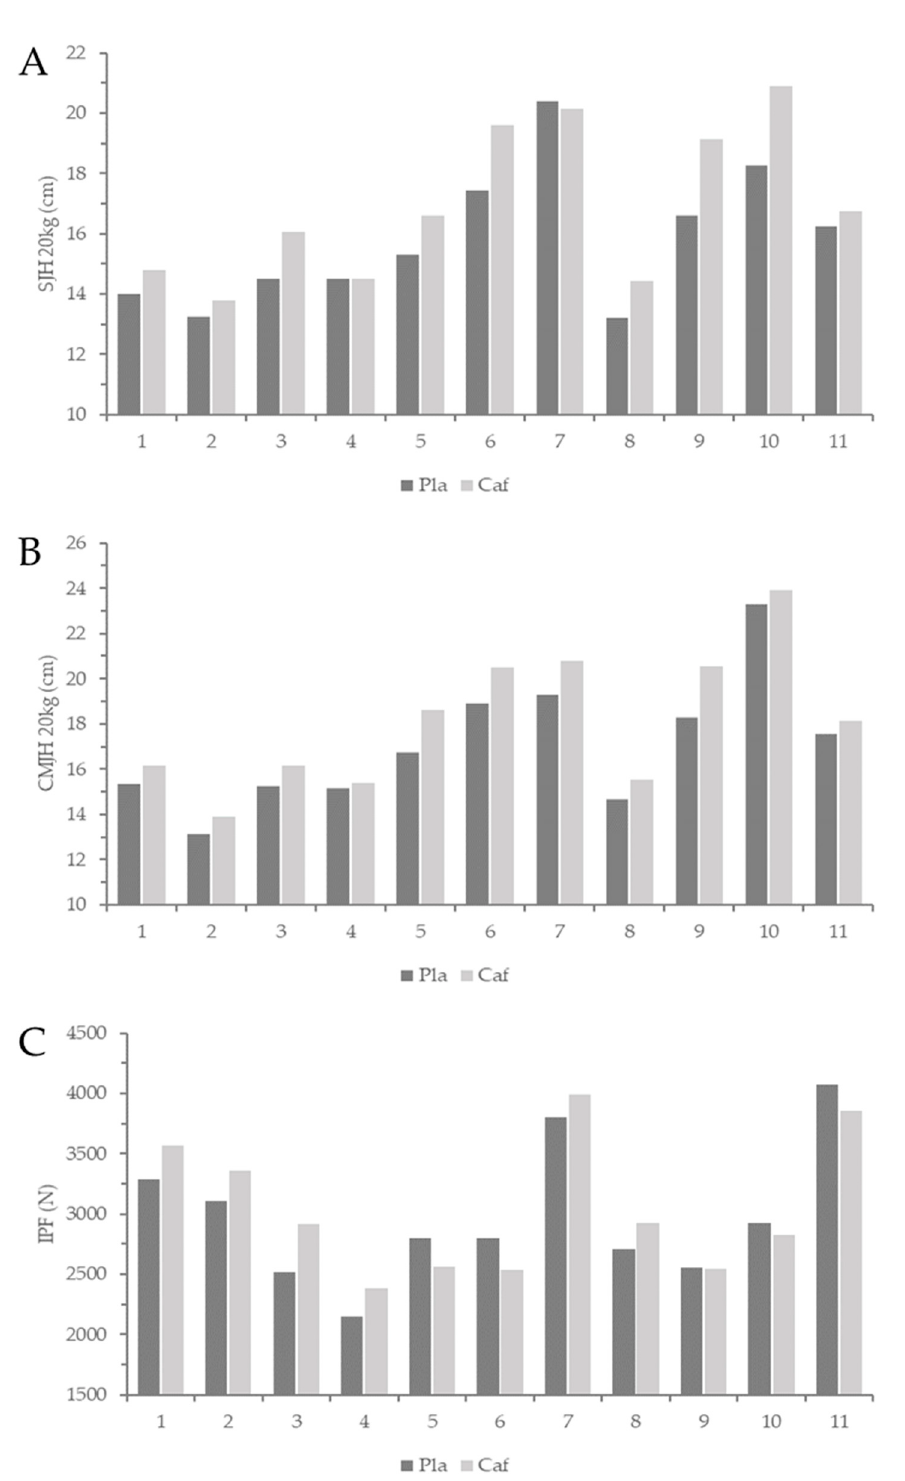
Figure 2. Individual changes in ( A ) SJH 20 kg = squat jump height with 20 kg, ( B ) CMJH 20 kg = countermovement jump height with 20 kg, and ( C ) IPF = isometric mid-thigh pull peak force. Nine of eleven athletes improved SJH 20 kg, 10 of 11 athletes improved CMJH 20 kg, and 6 of 11 athletes improved IPF in the caffeine condition over placebo relative to the typical error for each measurement. Pla = placebo, caf = caffeine.